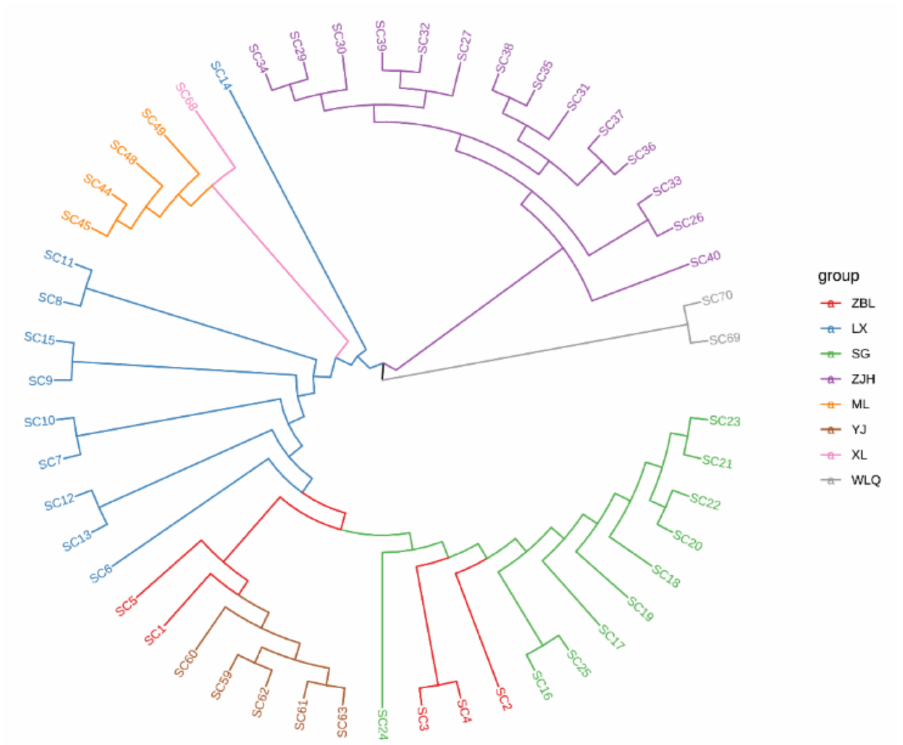
Figure 3. NJ phylogenetic tree of S. kozlovi populations. ZBL, SC1 − SC5; LX, SC6 − SC15;